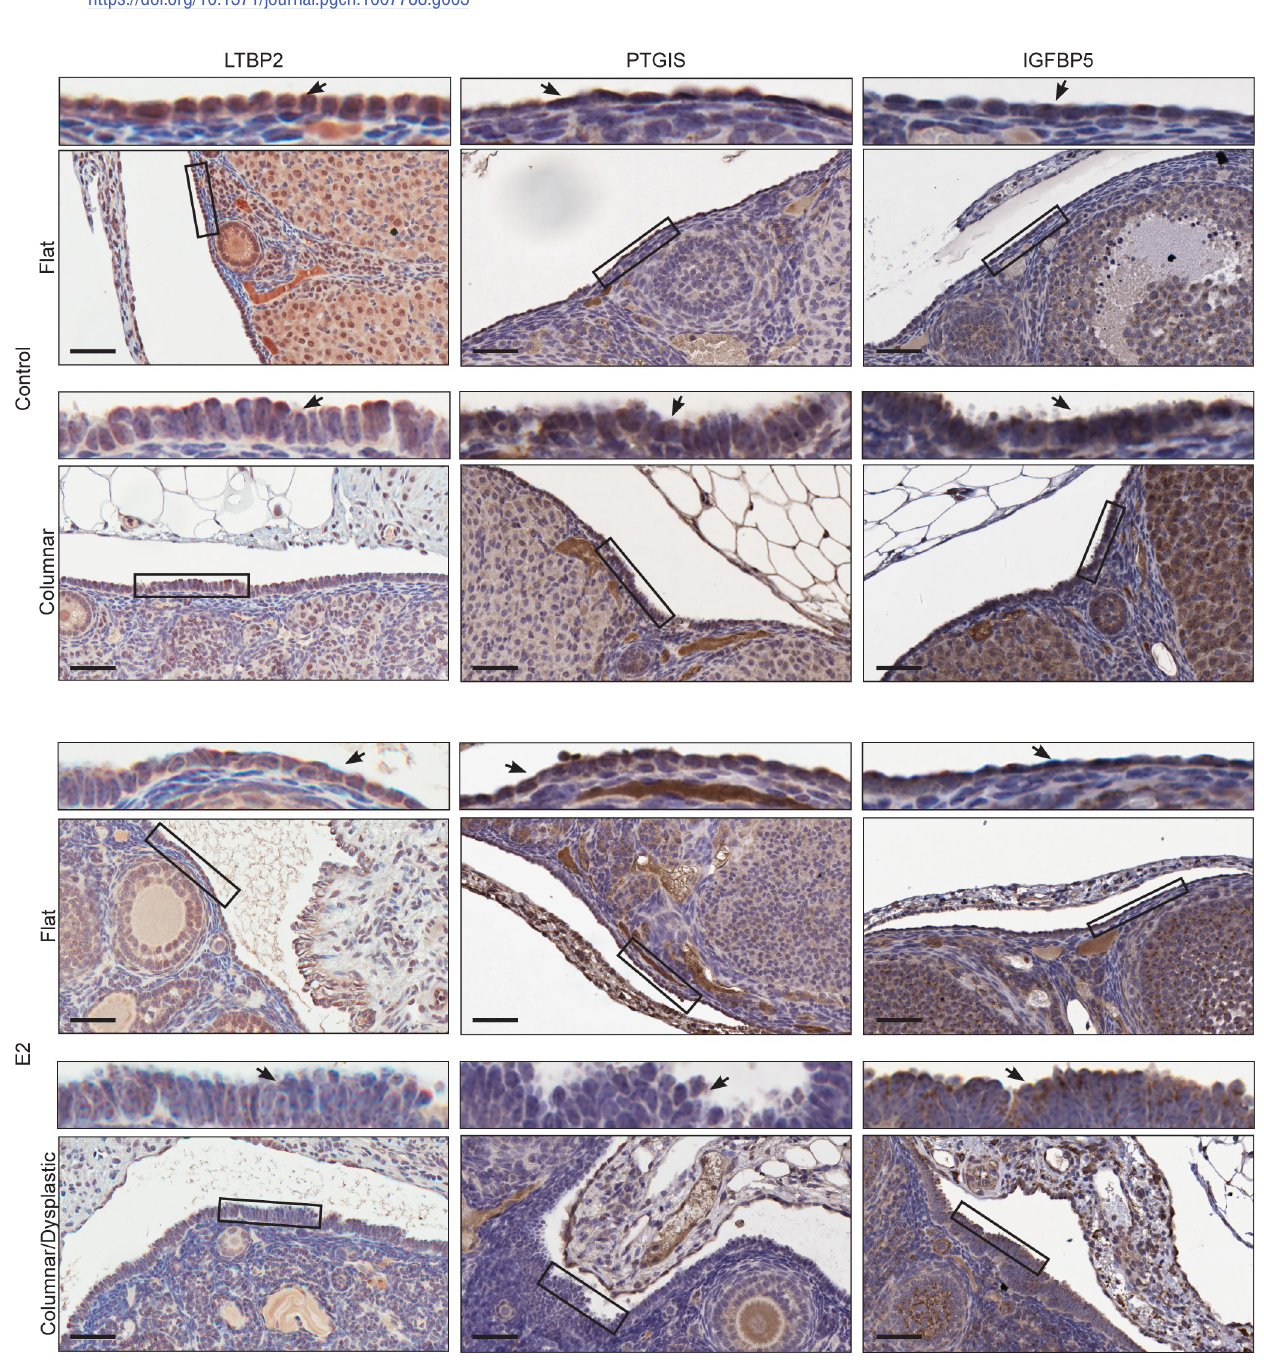
Fig 4. Cluster marker validation in vivo by IHC. IHC staining of ovaries from placebo and E2-treated mice for LTBP2 (placebo n = 3; E2 n = 5), PTGIS (placebo n = 5; E2 n = 5), and IGFBP5 (placebo n = 5; E2 n = 5). For each image, a higher magnification view of the OSE is provided above. Scale- bar = 50 μ m. See supplementary ( Figure in S9 Fig ) for IHC “no primary” controls.